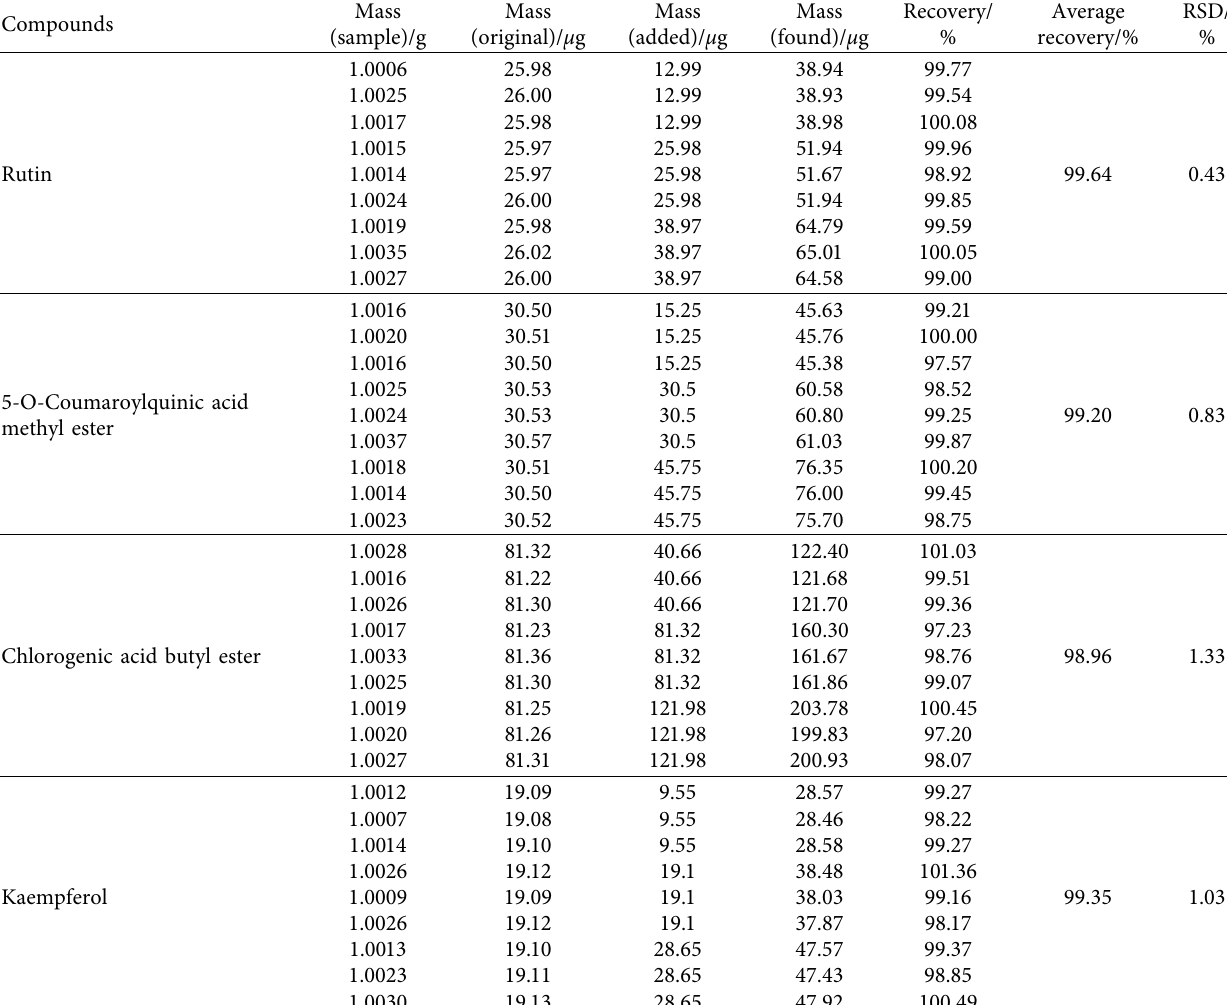
Table 3: Test results of sample recovery ( n � 9).